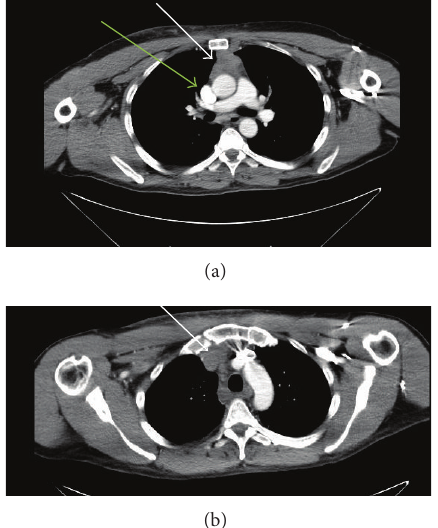
Figure 1: CT chest with contrast: 6/29/2014. Technique: contiguous transaxial images were obtained from the thoracic inlet to the upper abdomen with contrast. 125cc omnipaque 350. (a) Thrombosis of therightinternaljugularveinwithextensiontotherightinnominate vein and subclavian vein was noted (green arrow). The origin of the great vessels was patent. There was an anterior mediastinal mass (white arrow) present measuring 4.4×3.4 cm. Fibrotic changes were noted at the right base. There was no pulmonary mass or infiltrate. The thin cut after contrast series demonstrated no evidence of large pulmonary emboli. Fluid attenuation was noted just superior to the azygos arch likely representing prominence of the pericardial recess. There was a 2.8×1.1 cm lymph node in the subcarinal region image. There were prominent right axillary lymph nodes noted. (b) There was prominent soft tissue attenuation in the anterior mediastinum which was abutting the thrombosed jugular and innominate veins (white arrow). This was likely superior extension of the previously mentioned anterior mediastinal mass.